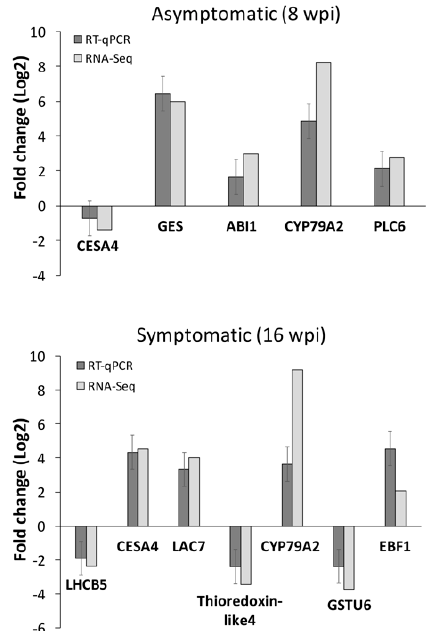
Figure 5. Validation of differential expressed genes. Ten differential expressed genes (DEGs) were selected from RNA-seq data and quantified by RT-qPCR at asymptomatic and symptomatic stages. A comparison between RT-qPCR results and results obtained from RNA-Seq analysis is shown.